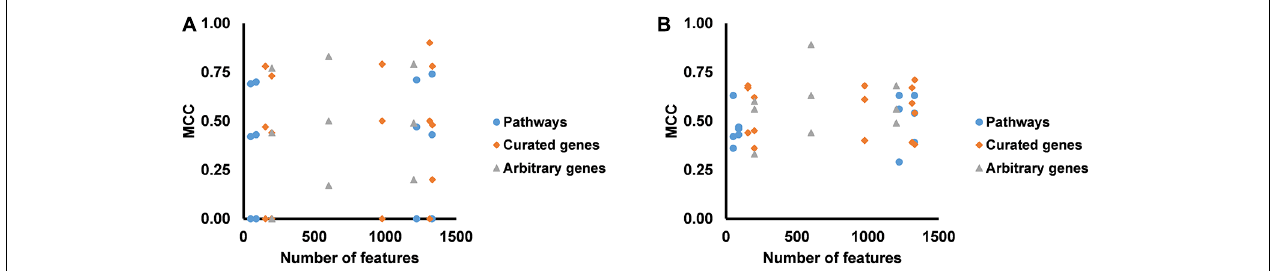
FIGURE 3 | (A) MCCs for predicting presence of one endpoint and absence of two endpoints for all feature sets. (B) MCCs for predicting presence of two endpoints and absence of one endpoint for all feature